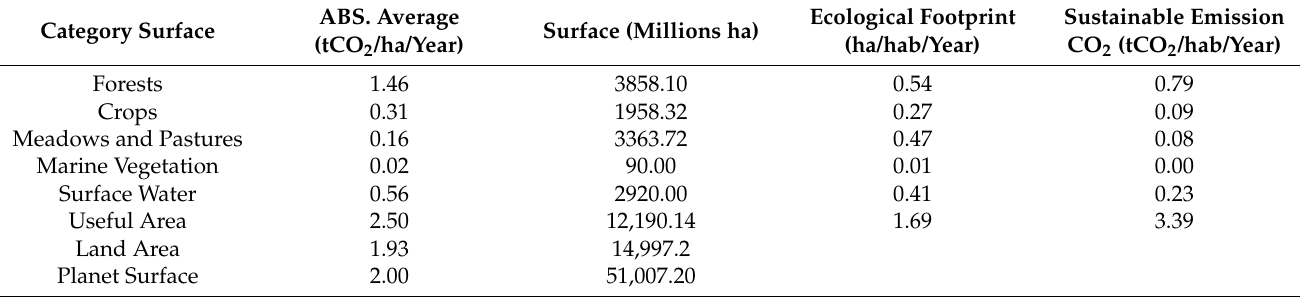
Table 14. Useful area, sustainable ecological footprint, and sustainable CO 2 emissions. (Llinares, 2005; Gobierno de Canarias,